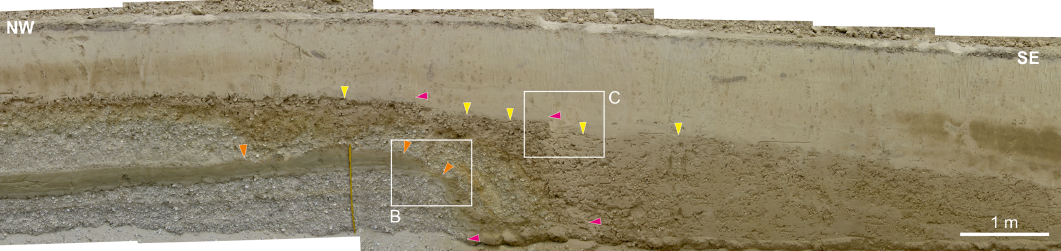
Figure 9. Trench WAG: photomosaic of the W-facing trench wall. Red arrows denote locations of faults. Yellow arrows point to offset contact between colluvium and overlying loess. Orange arrows denote location of the faulted marker layer depicted in Fig. 10. Boxes refer to details shown in Fig. 10b and c.